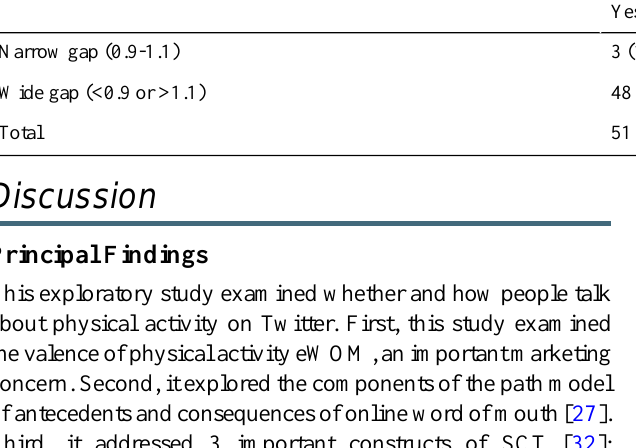
Total, nCompanionship support, n (%)Gaps between number of followers and